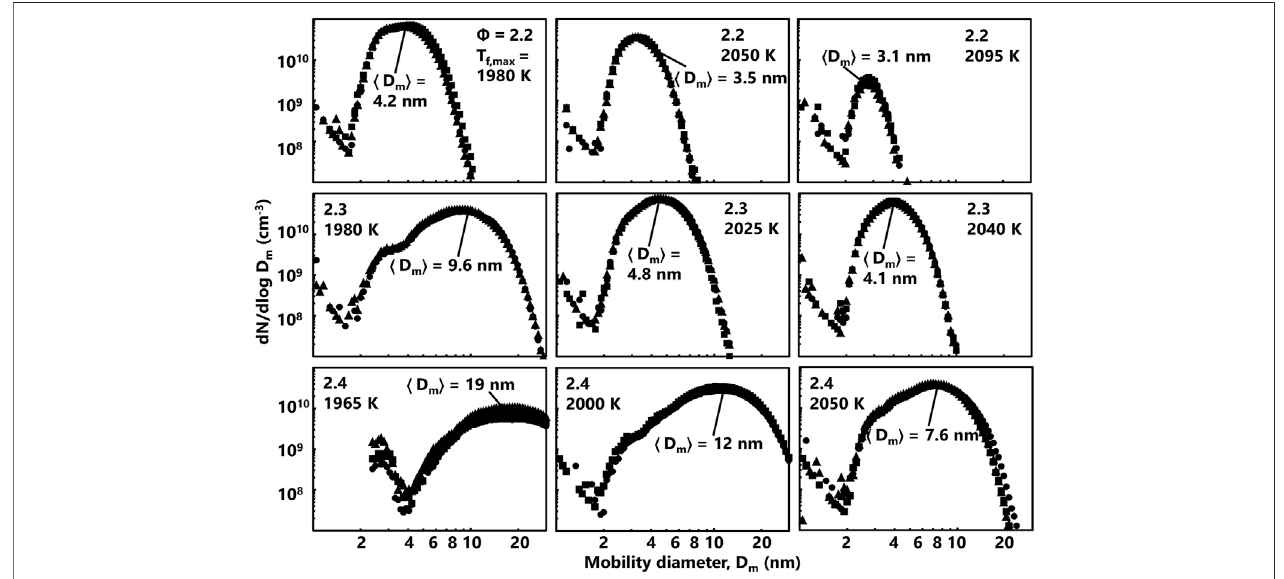
FIGURE 3 | Measured PSDF for the series of fl ames currently studied. The PSDF measurement is repeated three times and different symbols are used to highlight repeated measurements. The median diameter, < D m > , is labeled for each fl ame condition as well.